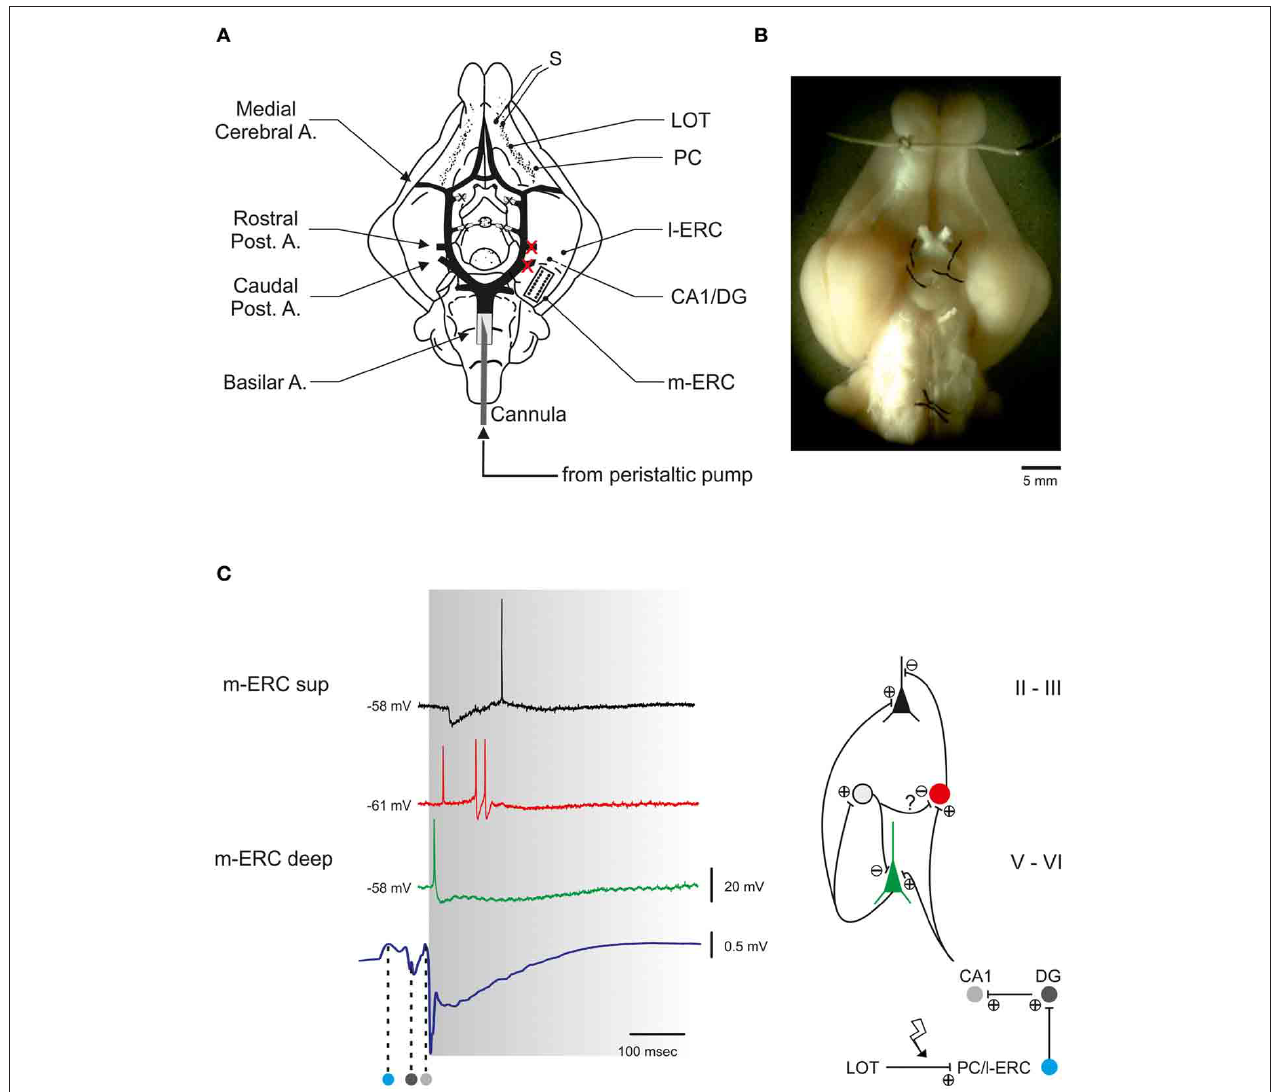
FIGURE 4 | The guinea pig isolated whole brain (IWB). (A) Schematic view of IWB observed from its ventral surface. The circle of Willis with its principal branching arteries is highlighted in black. The whole brain is perfused by means of a peristaltic pump that delivers ACSF to the brain through a polyethylene cannula inserted into the basilar artery. The two vessels that are occluded to induce the hippocampal ischemia are marked by red crosses. In the same hemisphere a microelectrode array (MEA) is positioned in the center of the m-ERC (delimited by dotted line). S, stimulating electrode; LOT, lateral olfactory tract; PC, piriform cortex; l-ERC, lateral entorhinal cortex; DG, dentate gyrus; m-ERC, medial entorhinal cortex. (B) Stereomicroscope photograph of the isolated brain positioned in the perfusion chamber. (C) Electrical responses to LOT stimulation recorded in the m-ERC. Left, intracellularly recorded voltage traces from a superficial pyramidal cell lying at 200–300 μ m from pial surface (black trace), a